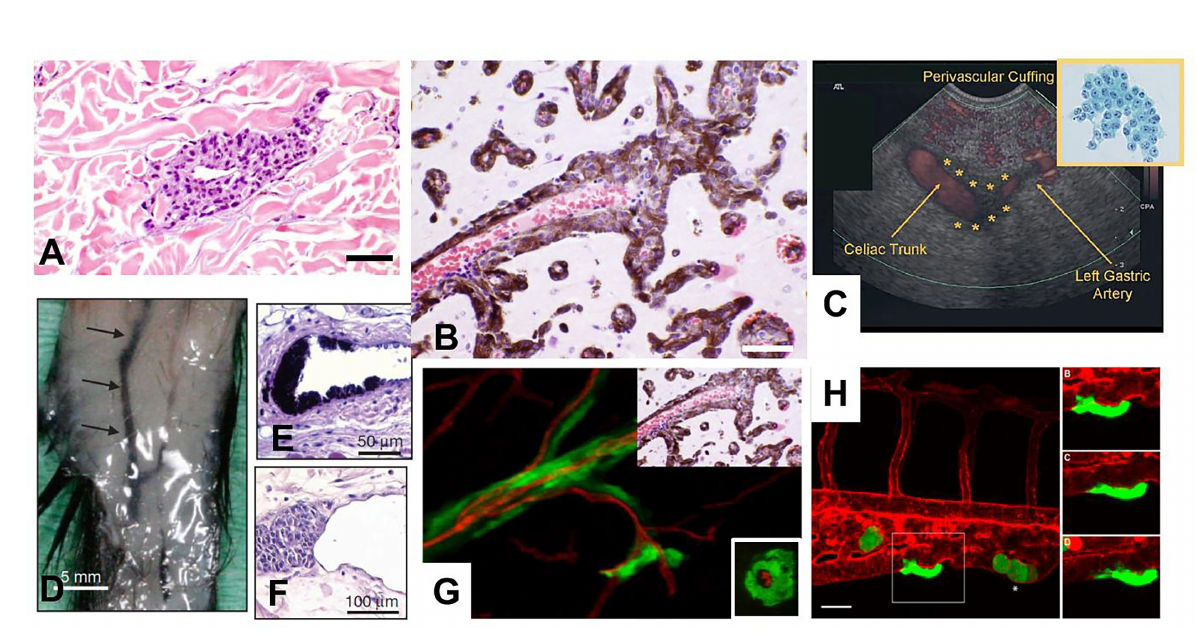
FIGURE 3 Angiotropism and angiotropic EVMM. (A) Human sample of melanoma showing angiotropism of tumor cells about the abluminal surface of a microvessel, some distance from the primary melanoma (about 1 mm) constituting an angiotropic microscopic satellite in the nearby dermis. Melanoma cells (dark purple cells) are cuf fi ng the abluminal surface of the microvascular channel. Scale bars: 40 µm. (B) Human sample of a melanoma metastsis to the brain. Microvessels ( fi lled by red blood cells) are extensively coated by a layer of melanin – containing melanoma cells, without intravasation, demonstrating signi fi cant angiotropism and PM. Scale bars: 100 µm. (C) Detection in a patient of EVMM from a remotely located pancreatic cancer in a patient (47). Linear endoscopic ultrasound and power doppler demonstrate a thin hypoechoic band (cuf fi ng) surrounding the celiac trunk, with extension along the left gastric artery. Up-right insert: Cytologic analysis of the endoscopic ultrasound fi ne-needle aspiration of malignant perivascular cuf fi ng around the celiac trunk specimen reveals a metastasis from a well- differentiated pancreatic adenocarcinoma (Papanicolaou stain). (D – F) . Pericytic mimicry (PC) and angiotropism in a genetically engineered mouse model. (D) Macroscopically visible melanoma cell expansion along 25 mm of a dermal blood vessels (arrows). Scale bars: 5